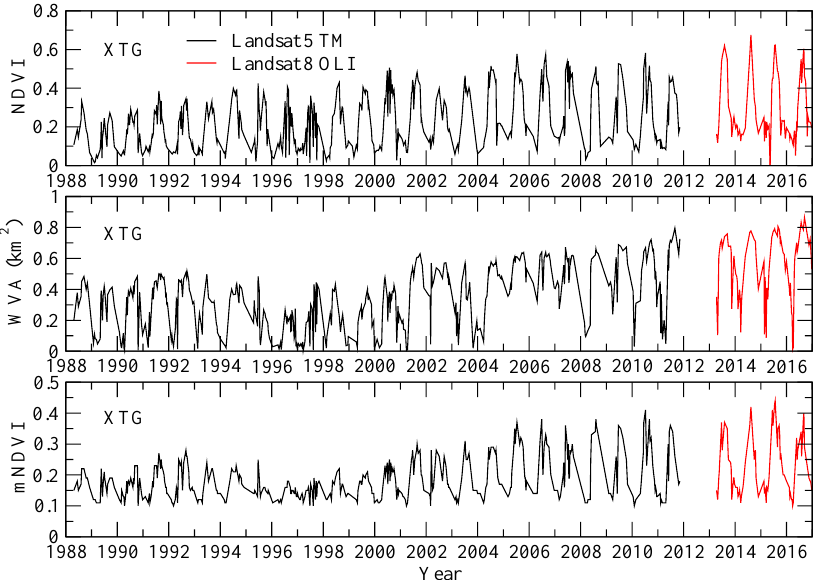
Figure 9. The time series plots of NDVI at the XTG’s typical wetland vegetation pixel ( top ), the wetland vegetated area ( center ), and the spatial mean NDVI ( bottom ) in the XTG.